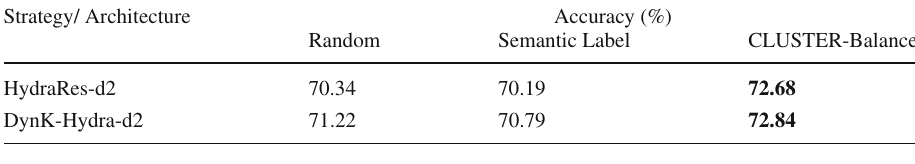
Table 6 Trade-off between the model accuracy and inference Flops by varying the threshold τ applied on the gater prediction and the average number of branches activated λ on Food-101 data